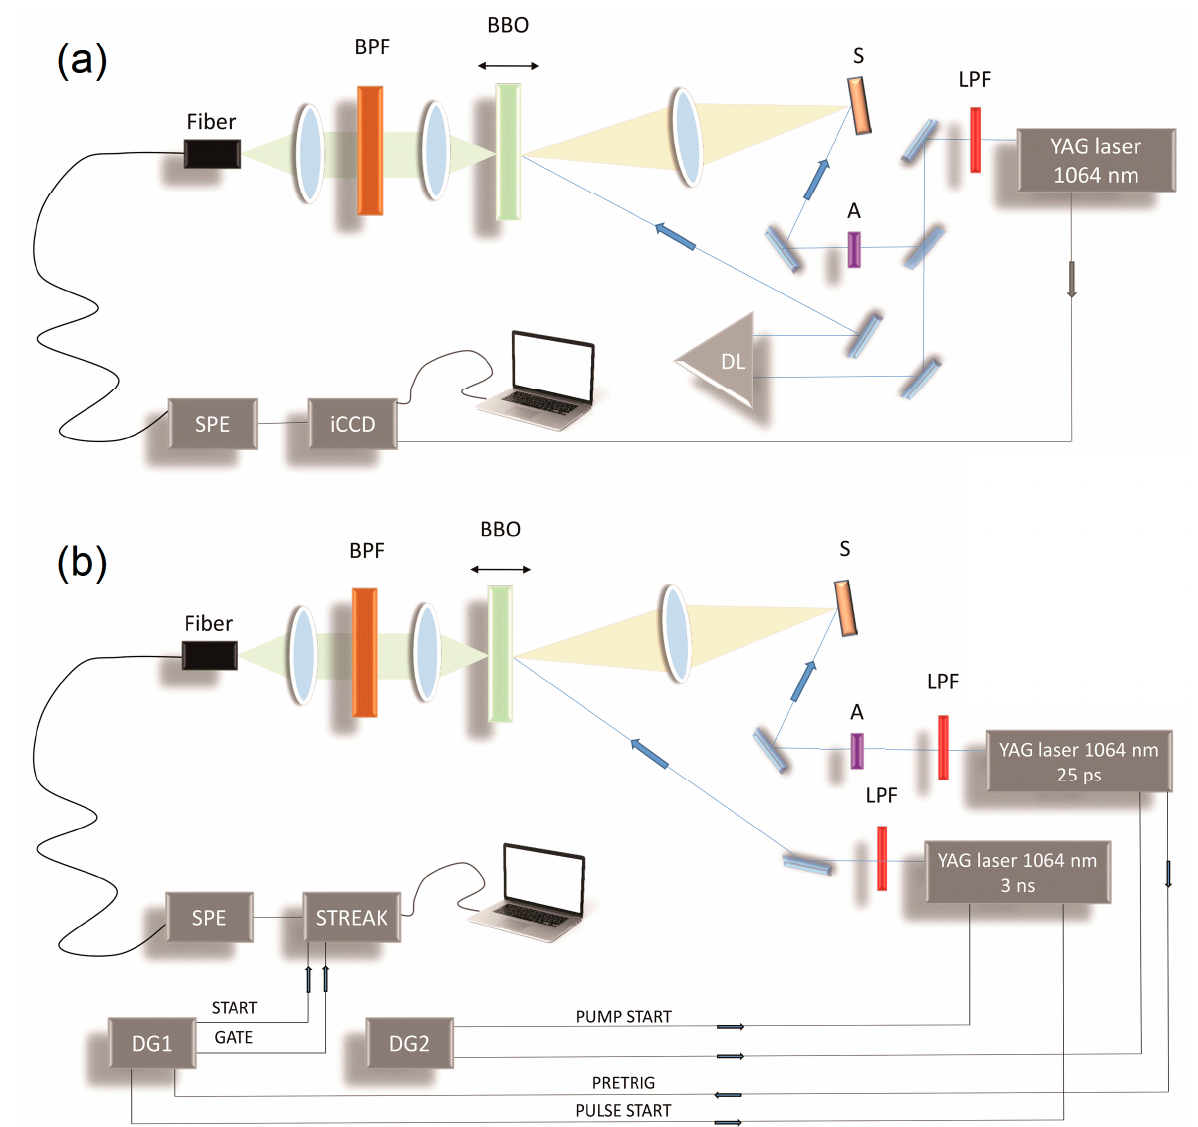
Figure 2. Experimental time-resolved photoluminescence setups: gated upconversion ( a ) and streak camera upconversion ( b ). Here SPE—spectrometer; DG1, DG2—delay generators; DL—delay line, S—sample, LPF—low pass filter for laser flash lamp block, A—excitation energy attenuator.